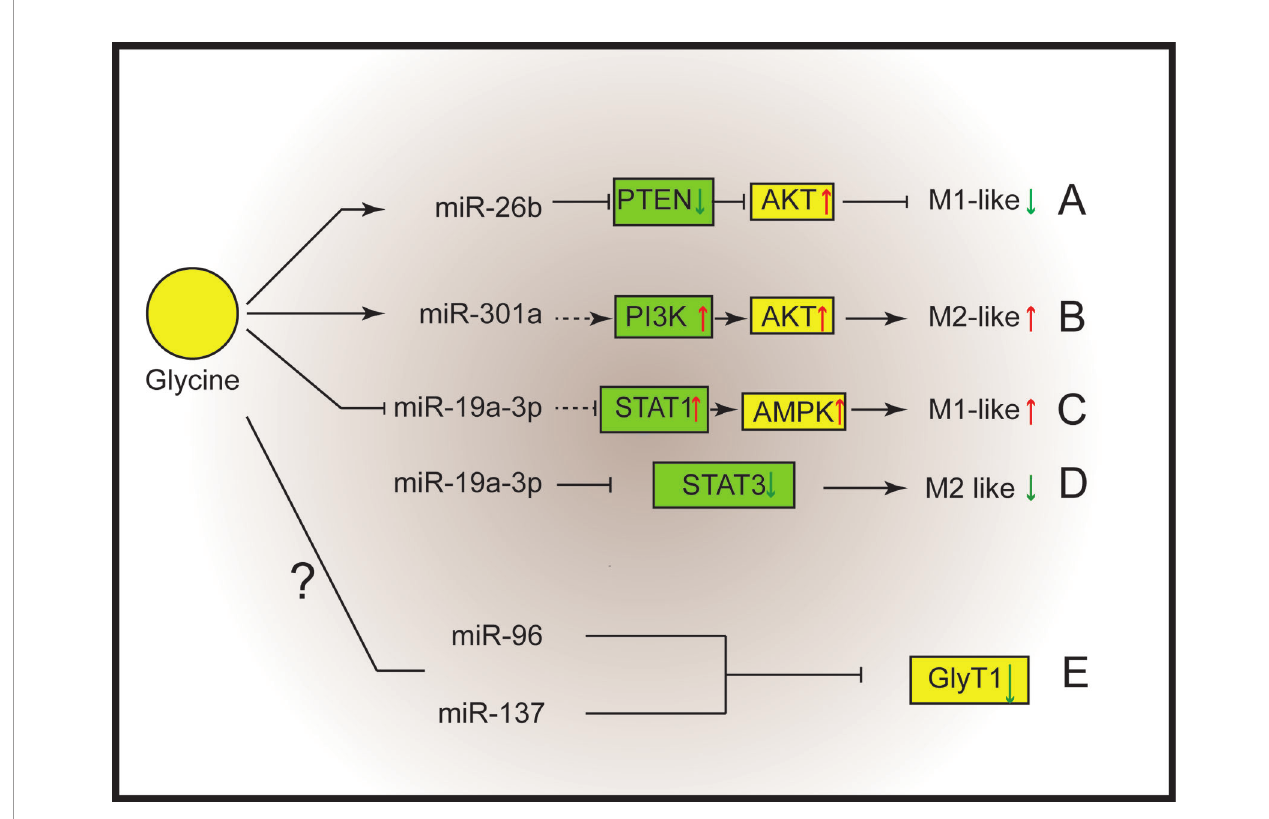
FIGURE 2 | Glycine shapes macrophage polarization through micro-RNAs. (A) Glycine up-regulates miR-26b to blunt M1-microglia polarization by suppressing PTEN and activating Akt. (B) Glycine possibly up-regulates miR-301a to promote M2-macrophages polarization via activating PI3K/Akt. (C, D) Glycine down- regulates miR-19a-3p. (C) MiR-19a-3p negatively control STAT1 and AMPK to blunt M1-macrophages polarization. (D) MiR-19a-3p negatively control STAT3 to inhibit M2 macrophage polarization. (E) MiR-96 and miR-137 negatively regulate GlyT1. PTEN, phosphatase and tensin homolog deleted on chromosome ten; Akt, protein kinase B; STAT, signal transducer and activator of transcription; GlyT, glycine